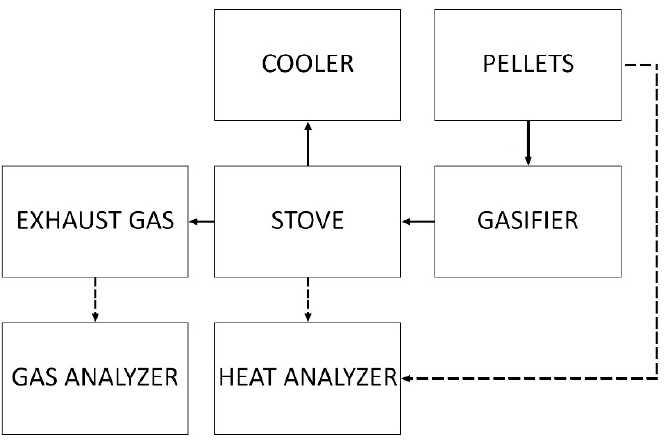
Figure 4. The scheme of experimental stand and measuring system.